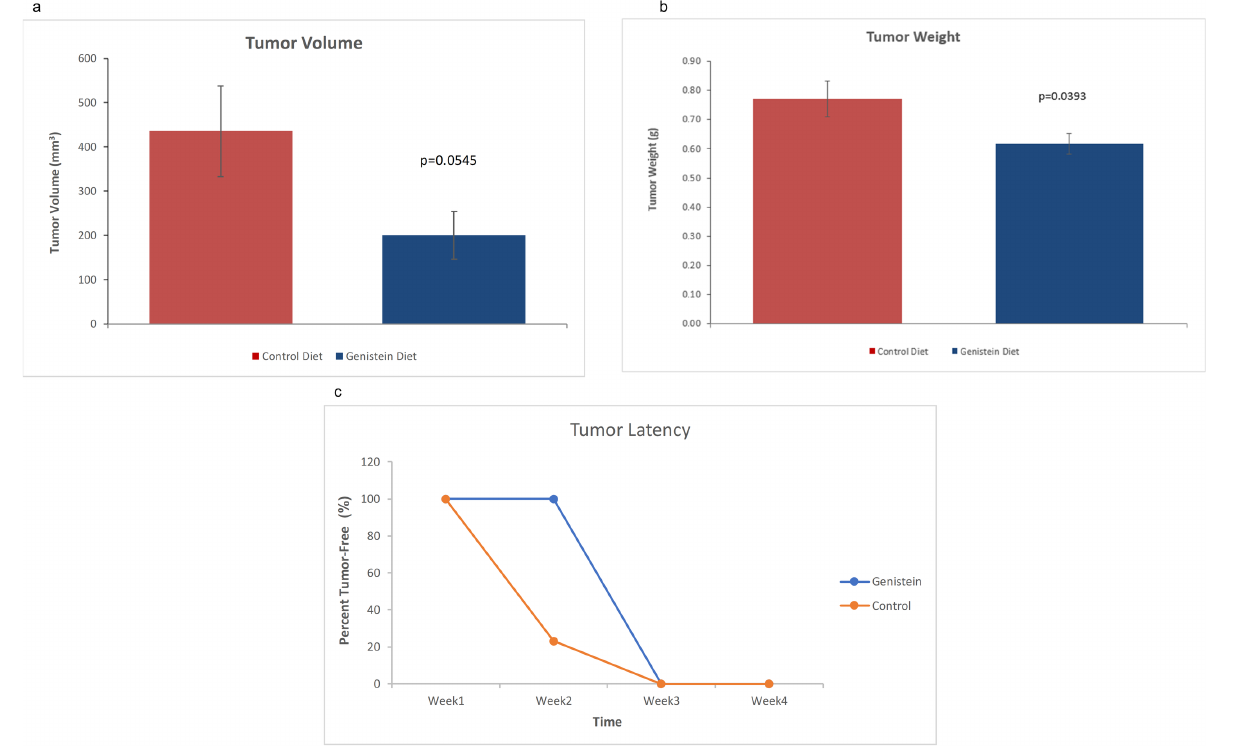
Fig 8. Tumor volume, weight and latency comparisons between control and GE-fed diet groups. Female athymic nude mice were injectedwith MDA-MB-231 cells. GE or control diets were providedfrom four weeks prior to injection.(a) GE diet mice showeda nearly significantreductionin tumor volume. (b) GE diet mice showeda significantreduction in tumor weight relative to the control-fedgroup (n = 18/group).(c) Dietary GE increasedthe latency of tumor development by 25% for the humanizedmice that were on a GE diet as comparedto humanizedmice on a control